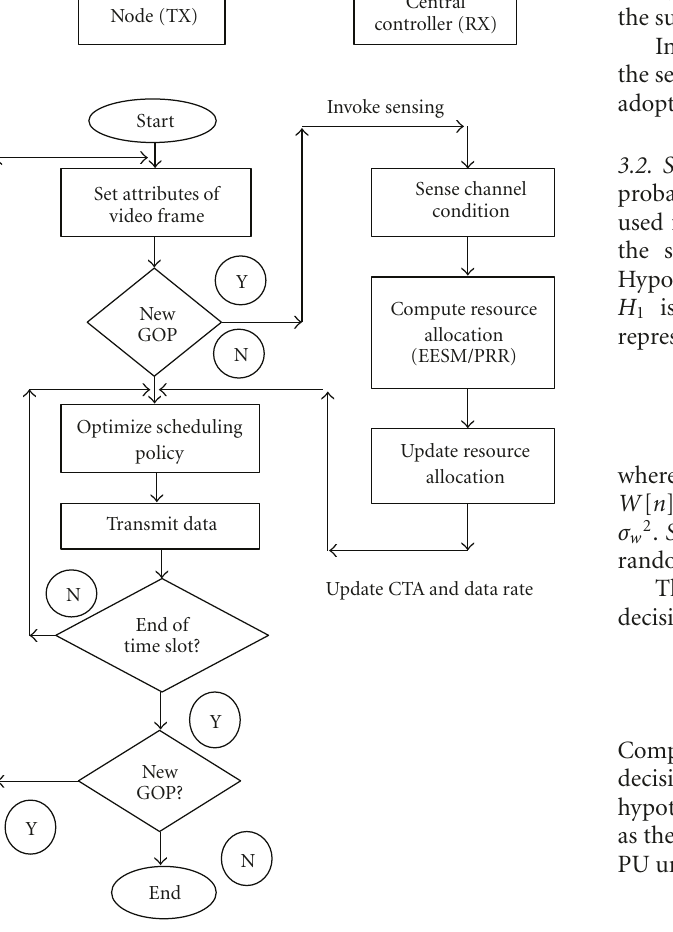
Figure 4: Interactions between C-UWB and central